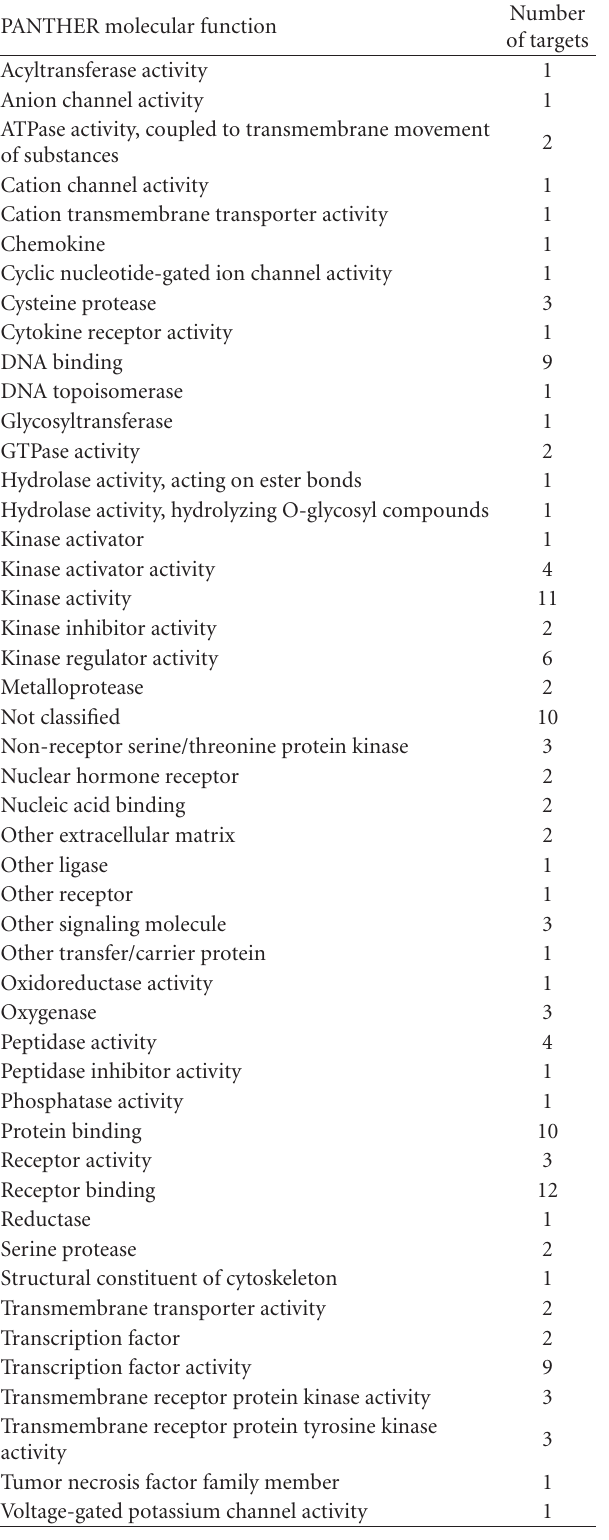
Table 3: Distribution of berberine’s targets in vitro according to molecular